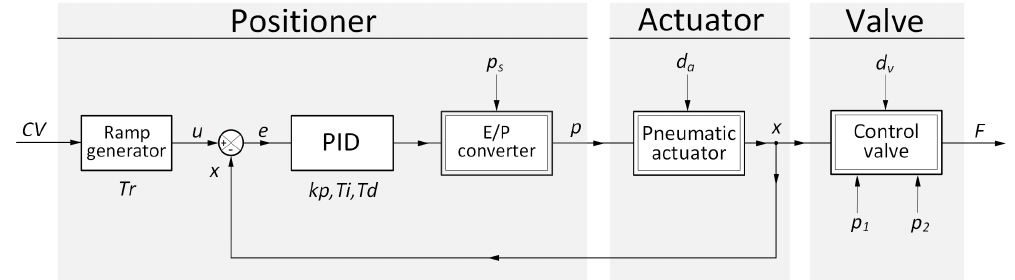
Figure 9. The structure of the final control element. Notations: d a —disturbances acting on the pneumatic actuator, d v —disturbances acting on the control valve, p 1 , p 2 —media pressures on the